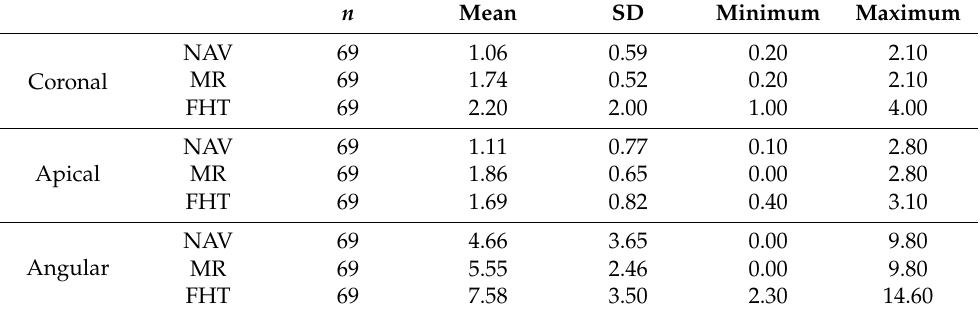
Table 1. Descriptive deviation values at the coronal entry-point (mm), apical end-point (mm), and angular ( ◦ ) levels of the orthodontic micro-screws placed by using conventional freehand technique, mixed reality technique and computer-aided static navigation technique study